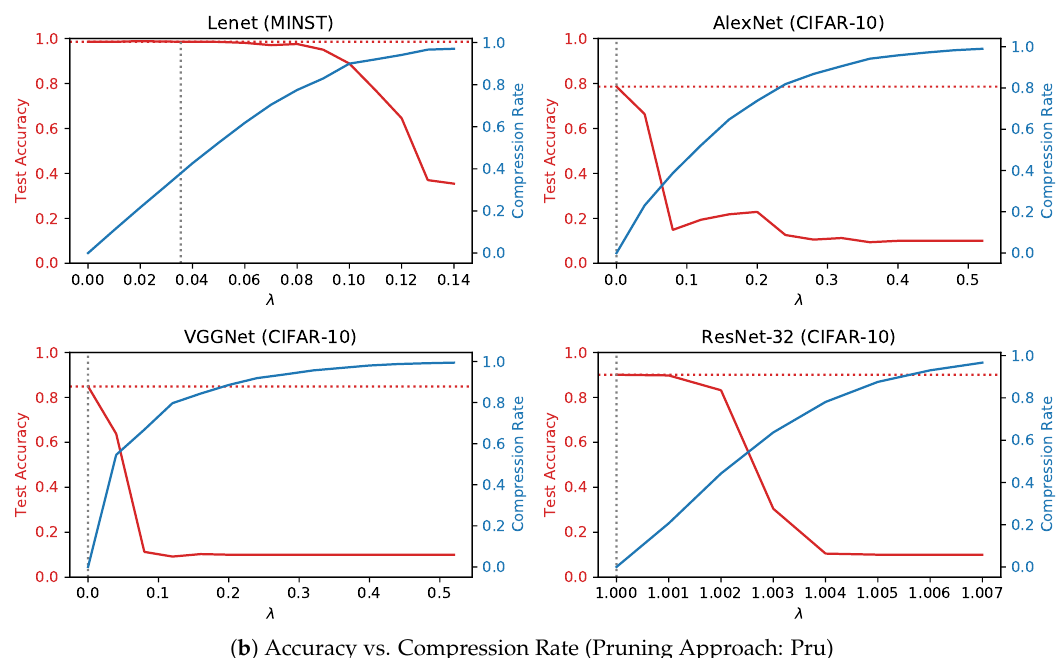
Figure 6. Compression rate and test accuracy with respect to the change of the λ parameter value, for ( a ) our sparse coding approach Spc and ( b ) the existing pruning approach. Higher λ values result in more compression with a decrease in prediction accuracy. ( a ) Spc: using sparse coding, about 90% of model parameters can be compressed achieving similar prediction accuracy to the reference models (test accuracy is shown as the horizontal dotted lines, and their crossings with accuracy curves of compressed models are marked as vertical dotted lines); ( b ) Pru: the existing pruning approach does not compress the networks as much: about 40% compression for Lenet-5 but no compression for the other networks at the similar accuracy level to the reference